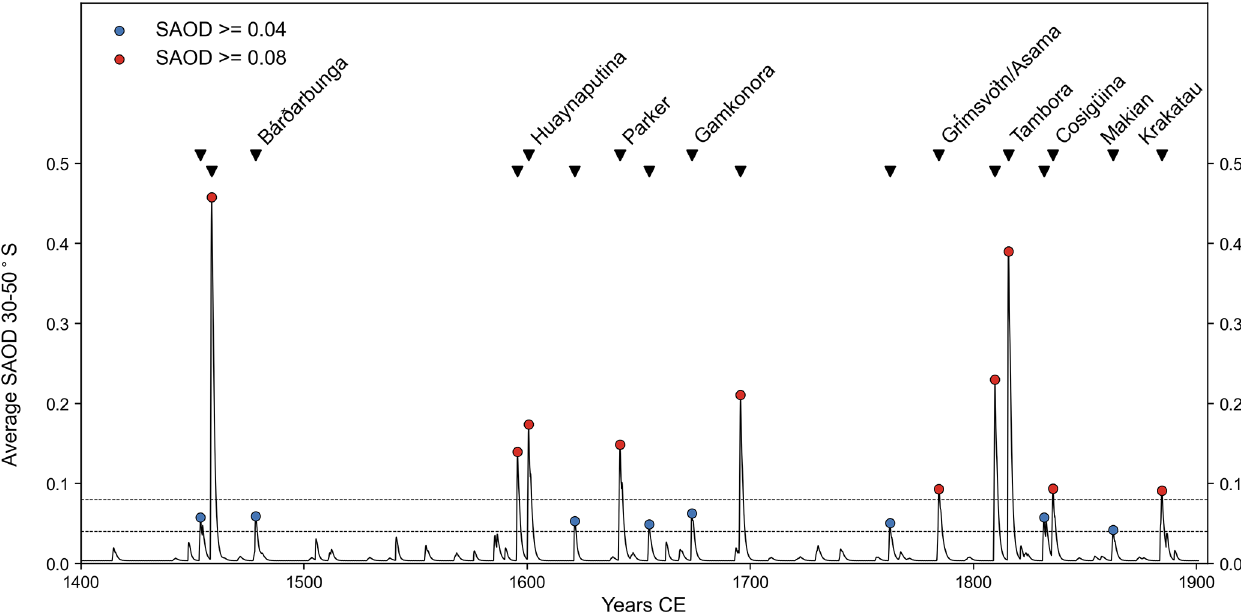
Figure 2. Selection of volcanic events based on thresholds of peak modelled stratospheric atmospheric optical depth (Toohey and Sigl, 2017), averaged over 30–50 ◦ S, greater than 0.04 (blue) and 0.08 (red). Known eruptions are